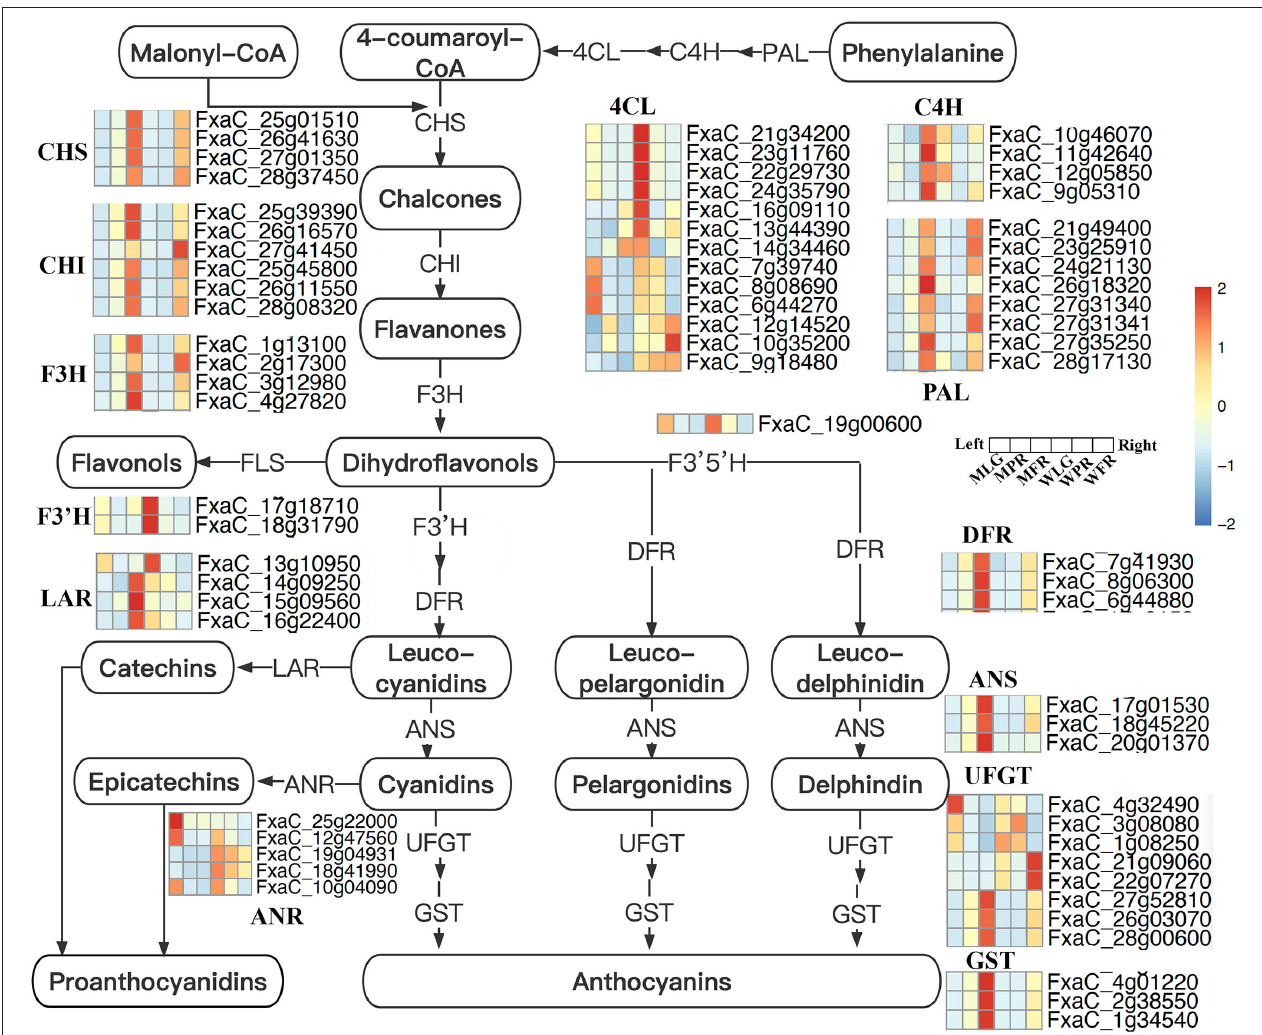
FIGURE 8 | Flavonoids biosynthesis pathway in strawberry. Genes expression were scaled using z -score of mean FPKM value from three biological replicates, represented by heatmaps at the side of each step. The cells from left to right indicated the large green, partial red, fully red stages of mutant, and normal ‘Benihoppe,’ respectively. The full names of each gene were shown in Supplementary Table S3